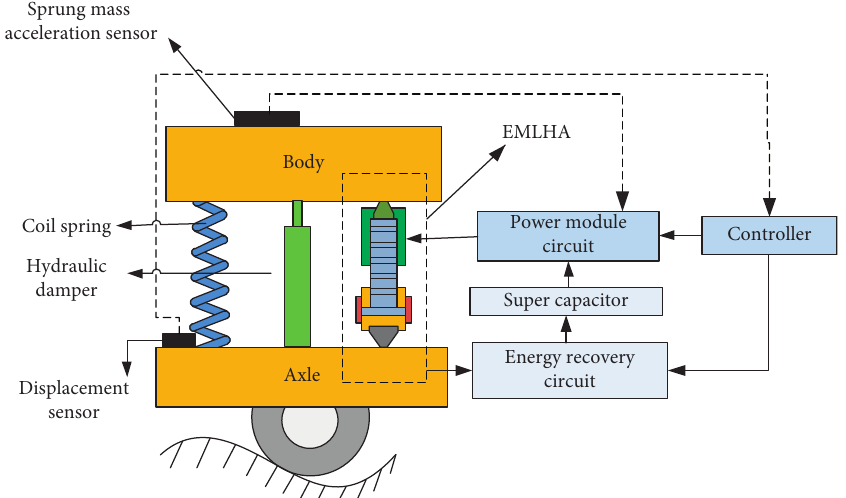
Figure 1: Structure of the EMLHAS system.